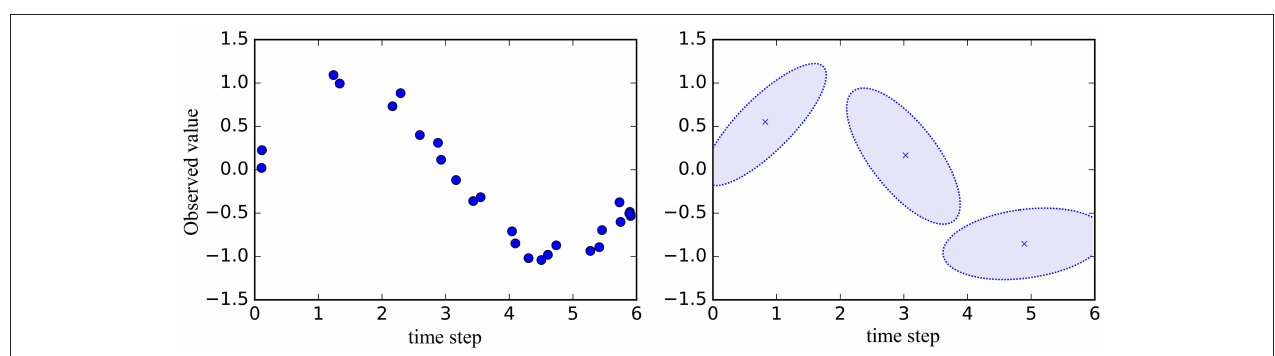
FIGURE 2 | Example of representation of time series data by HMM. Left: Data points for learning HMM. Right: Mean and standard deviation learned by HMM.